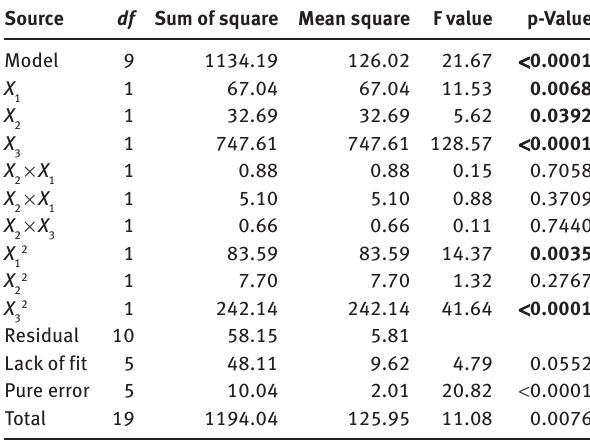
Table 3: ANOVA for coefficients of the